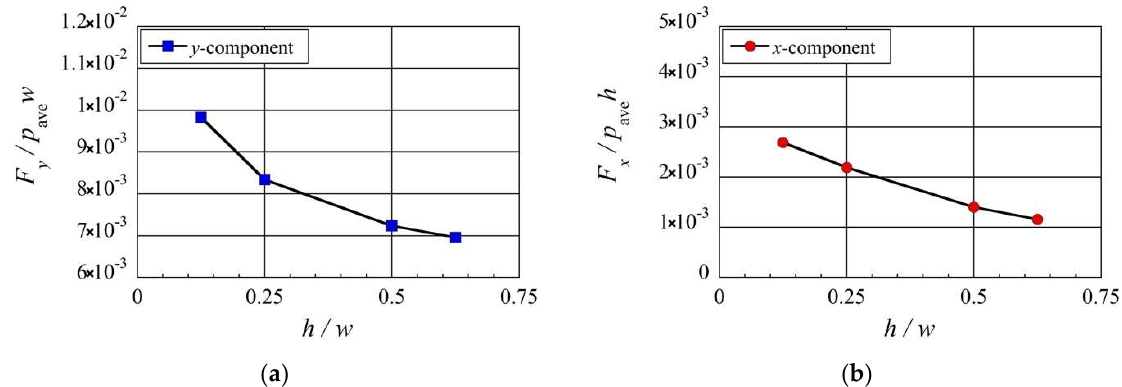
Figure 11. Net ( a ) upward and ( b ) rightward forces exerted on the four different beam heights, ℎ , at Kn = 0.2 .